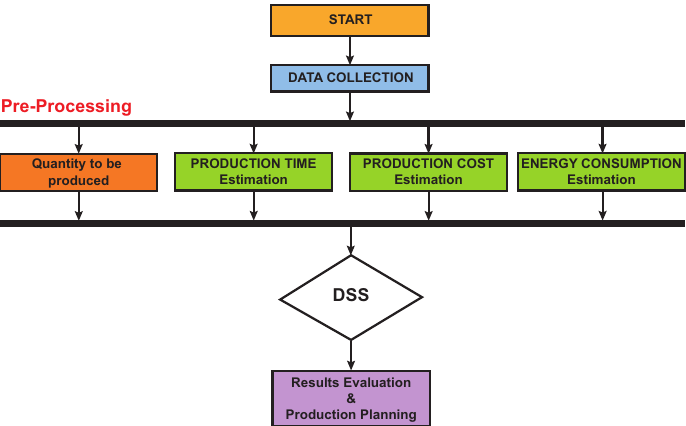
Figure 9. Extraction process selection.